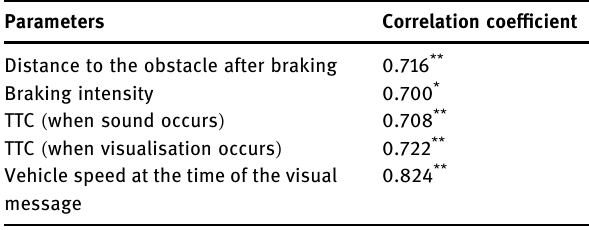
Table 11: Correlation of braking intensity with the rest of the parameters Parameters Correlation coe ffi cient Distance to the obstacle after braking